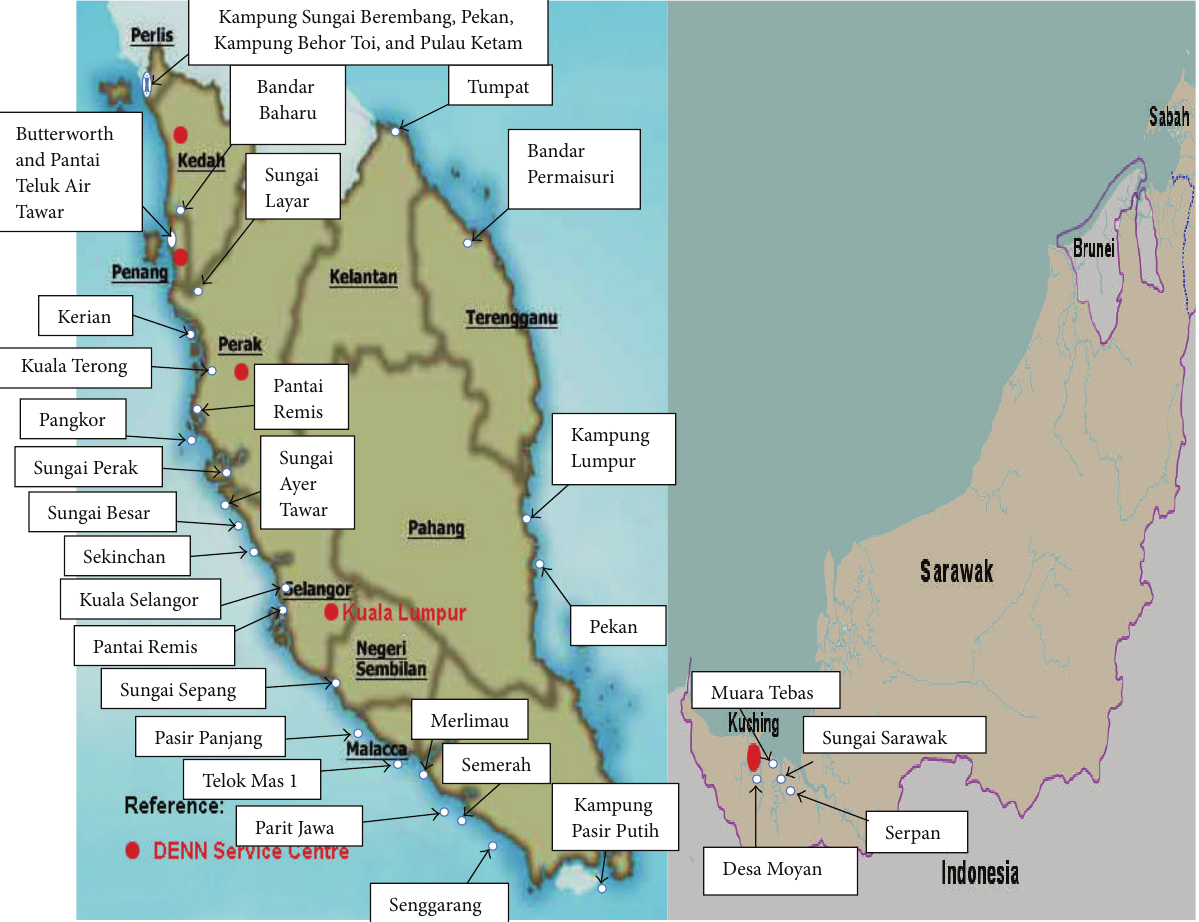
Figure 1: Map of Malaysian coasts showing sampling